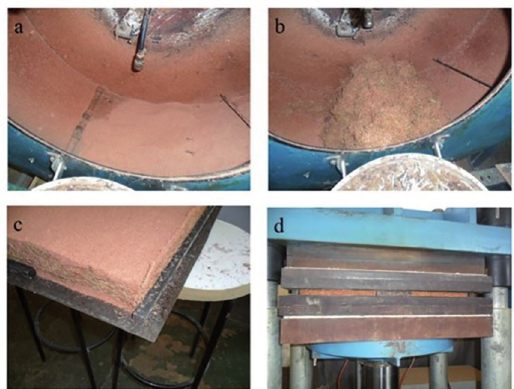
Figure 1: MDP production. (a) Adhesive application to smaller particles. (b) Adhesive application to bigger particles plus fibers. (c) Particle mattress after the pre-pressing. (d) Particle mattress during the hot